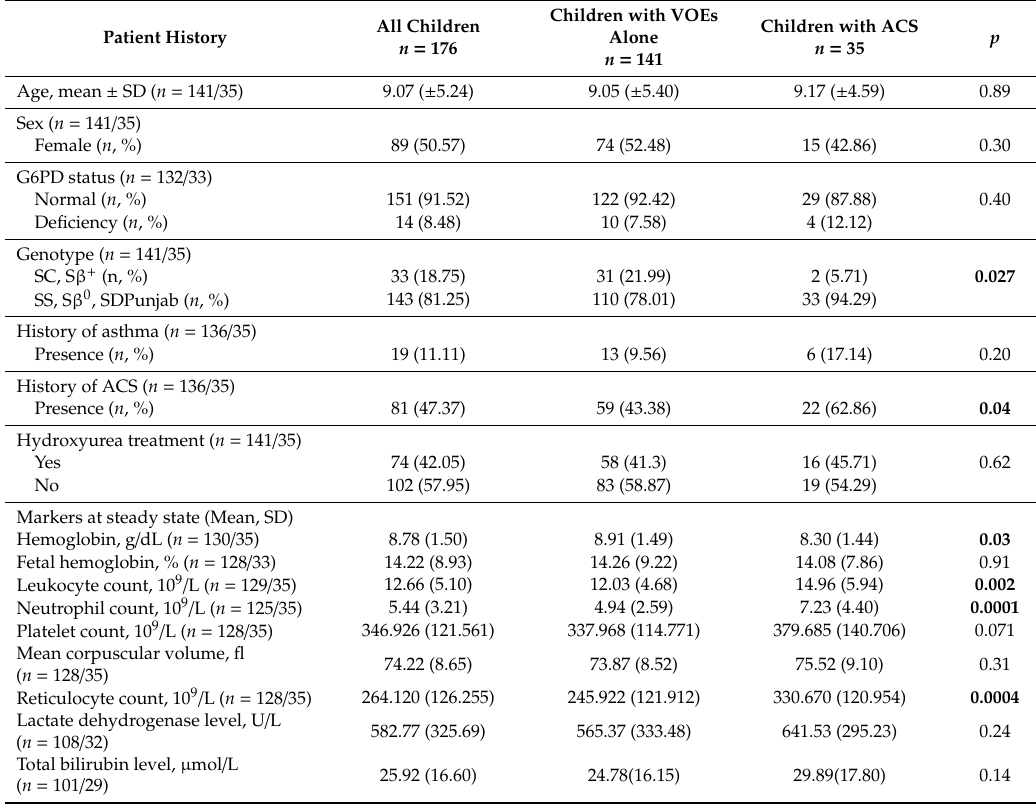
Table 1. Patient history and laboratory parameters at steady state according to the development of acute chest syndrome (ACS) after hospitalization for a vaso-occlusive episode (VOE) in children with sickle cell